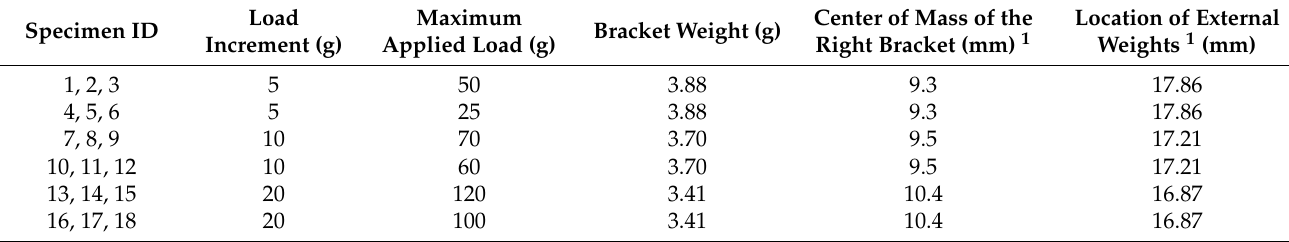
Table A2. Specimen loading